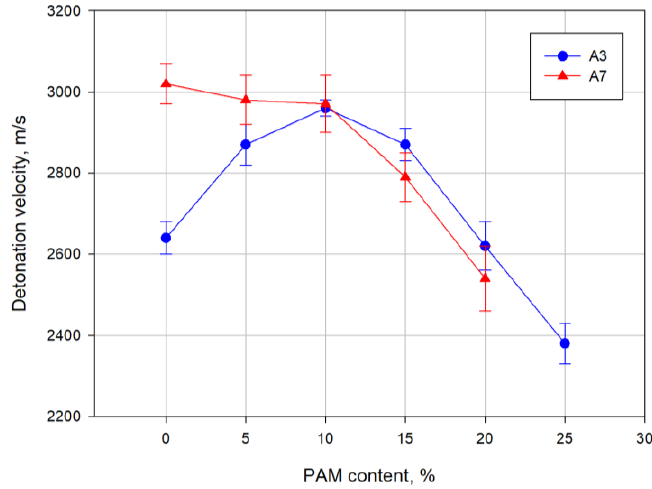
Figure 7. Experimental detonation velocity of the tested